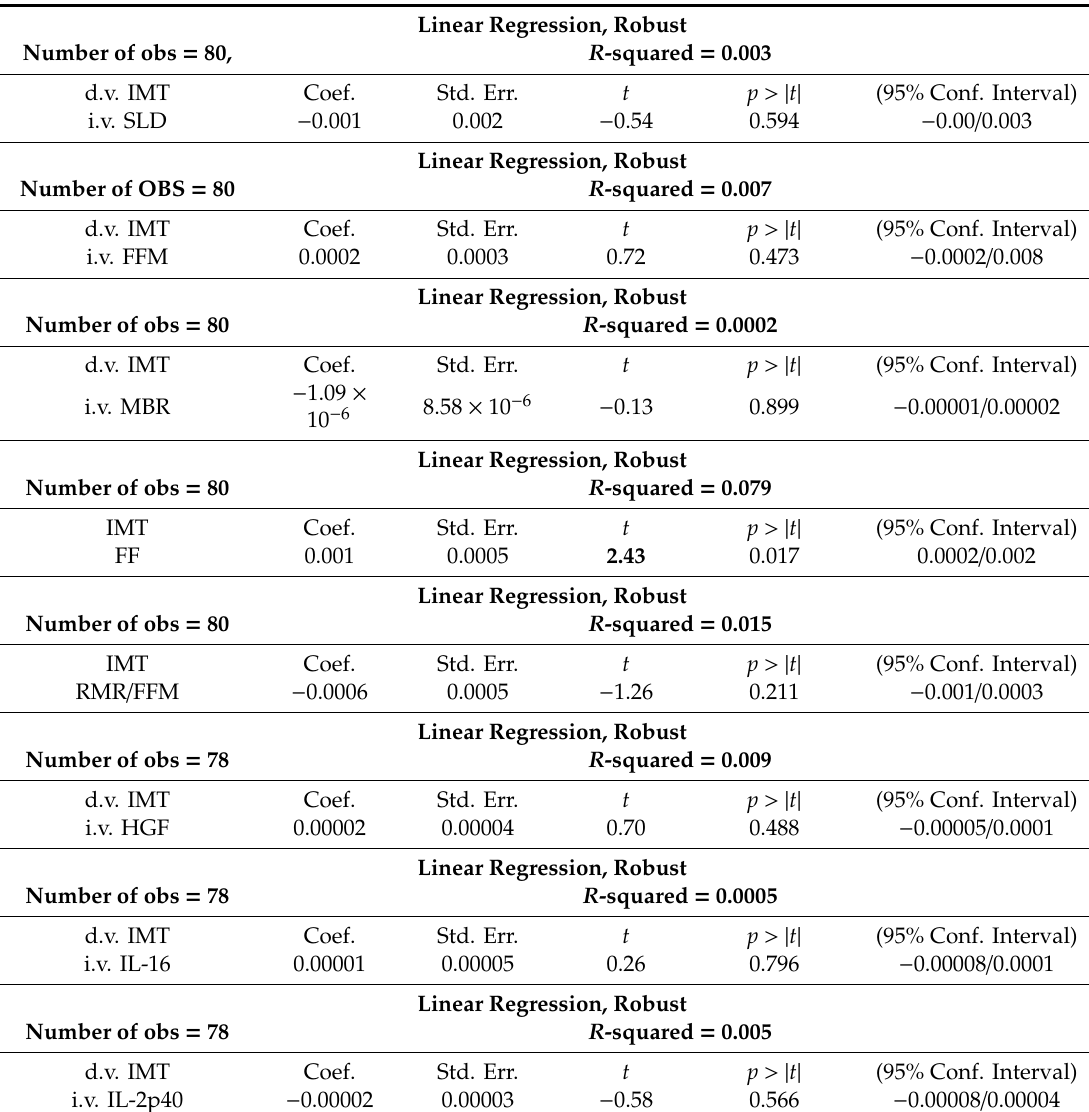
Table 4. Prediction of intima-media thickness (IMT) by SLD, fat-free mass (FFM), BMR, FF, fat-free mass (FFM), resting metabolic rate (RMR) / FFM ratio, IL-16 and IL-12p40.